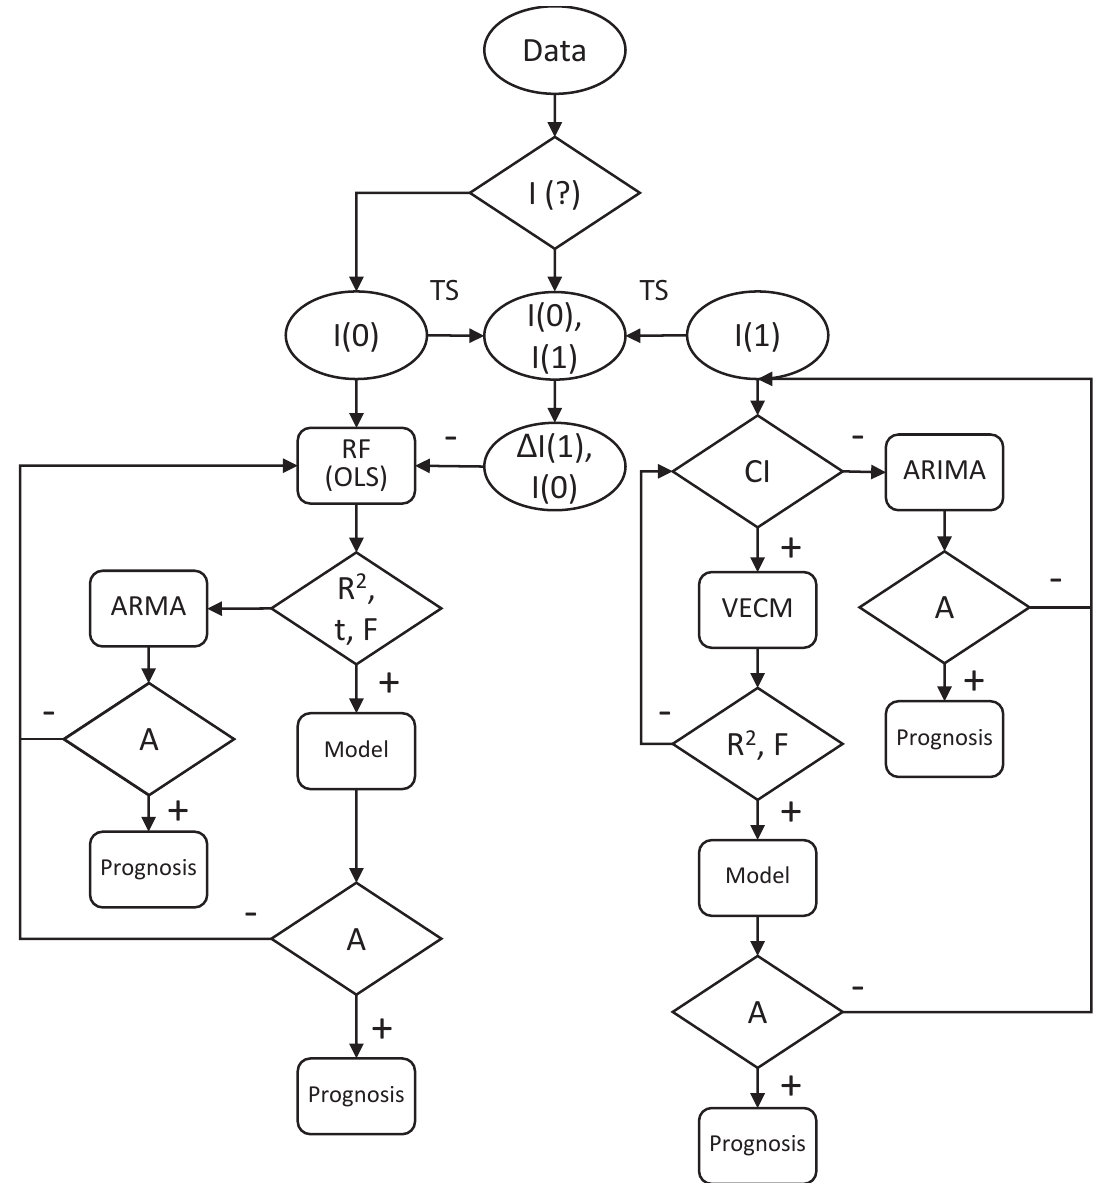
Figure 1. Financial state indicators forecasting process